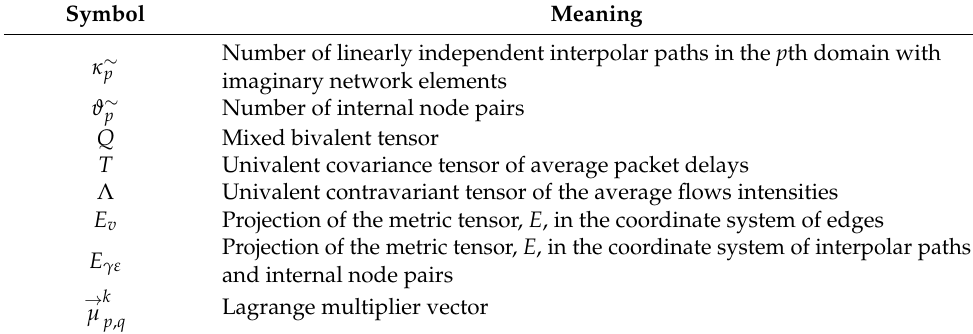
Table 2. Cont. Symbol Meaning Number of linearly independent interpolar paths in the p th domain with κ ∼ p imaginary network elements ϑ ∼ p Number of internal node pairs Q Mixed bivalent tensor T Univalent covariance tensor of average packet delays Λ Univalent contravariant tensor of the average flows intensities E v Projection of the metric tensor, E , in the coordinate system of edges Projection of the metric tensor, E , in the coordinate system of interpolar paths E γε and internal node pairs k → Lagrange multiplier µ p , q